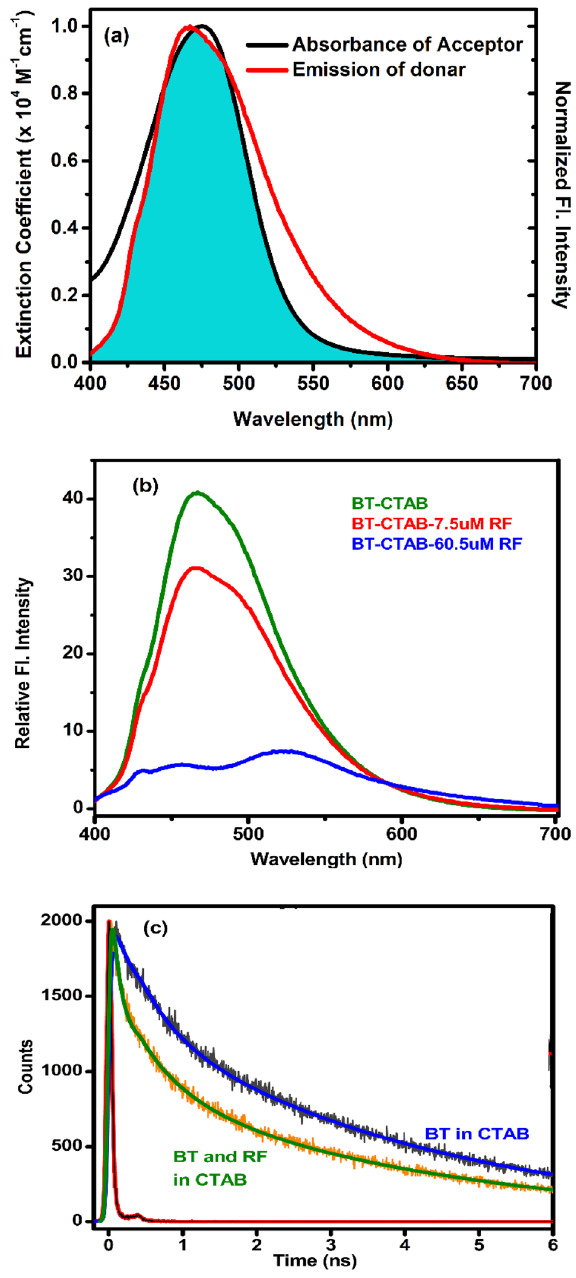
Figure 3. ( a ) Spectral overlap of BT fluorescence (Red) and RF absorbance (black) when both are incorporated in CTAB micelle. ( b ) Forster Resonance Energy Transfer (FRET) process is of BT ligand to RF within the CTAB micelle is evident from the quenching of the steady-state fluorescence intensity. ( c ) Picosecond-resolved fluorescence transients of the BT ligand as donor in CTAB micelle in absence and in presence of RF as an acceptor.